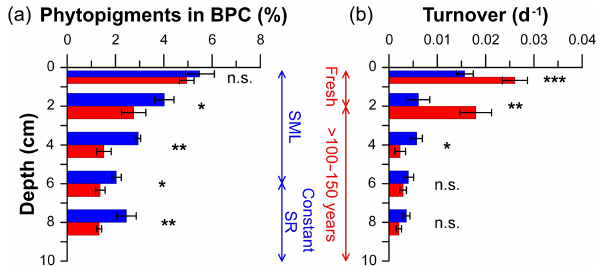
Figure 7. Organic matter freshness and degradation rates of trawled (red) and untrawled (blue) cores. Relative contribution of phytopig- ments to biopolymeric C (a) and protein turnover rates (b) . Bar graphs and error bars illustrate the mean values and standard er- rors at each site and depth of the triplicate sediment cores col- lected. Asterisks next to bars denote significance of post hoc permu- tational pairwise tests between trawled and untrawled sites: ∗ p < 0 . 05; ∗∗ p < 0 . 01; ∗∗∗ p < 0 . 001; n.s. denotes not significant. Verti- cal scales indicate the process that has occurred in the depth range given for both untrawled (blue) and trawled (red) sediment